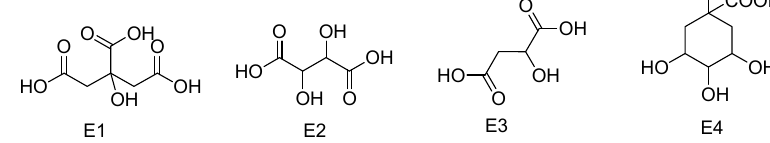
Figure 10. Structures of the non-phenolic compounds.